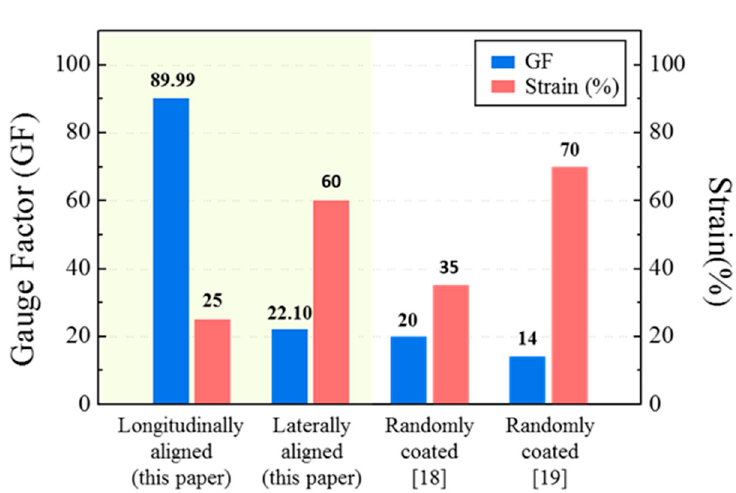
Figure 11. Graph comparing the gauge factor (GF) and strain ranges of the longitudinally and laterally aligned strain sensors between this study and previous studies.